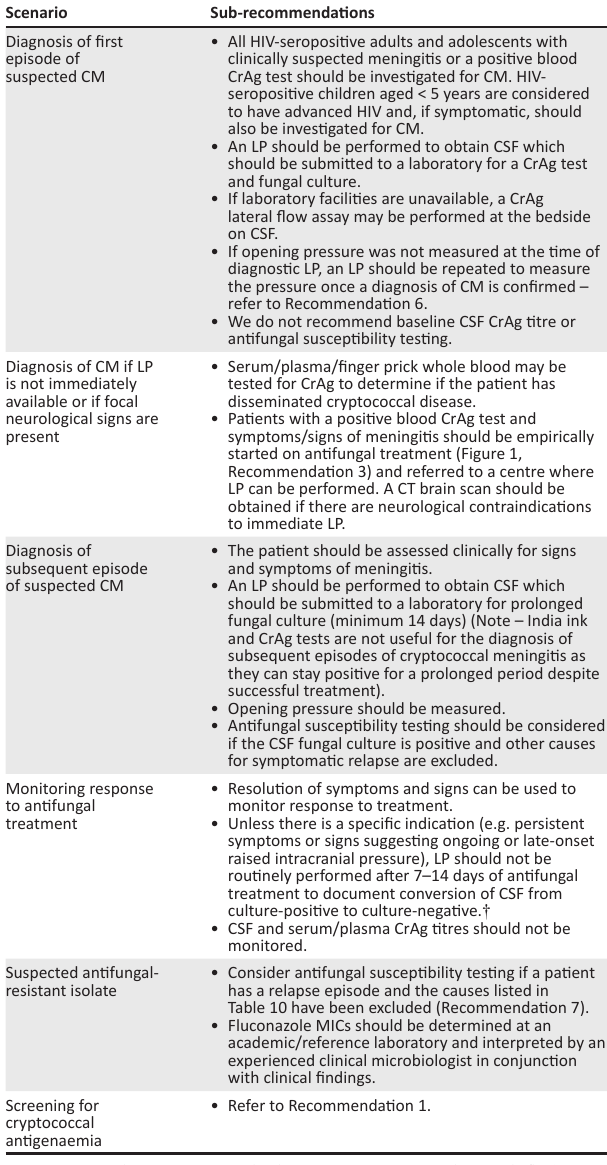
TABLE 2: Summary of recommendation